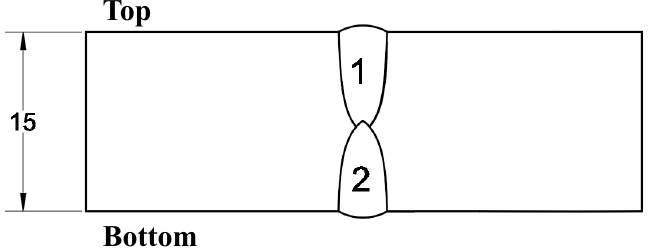
Figure 11. Cross-section of 2-pass butt welding for 15 mm thickness high-manganese steel by fiber laser equipment.